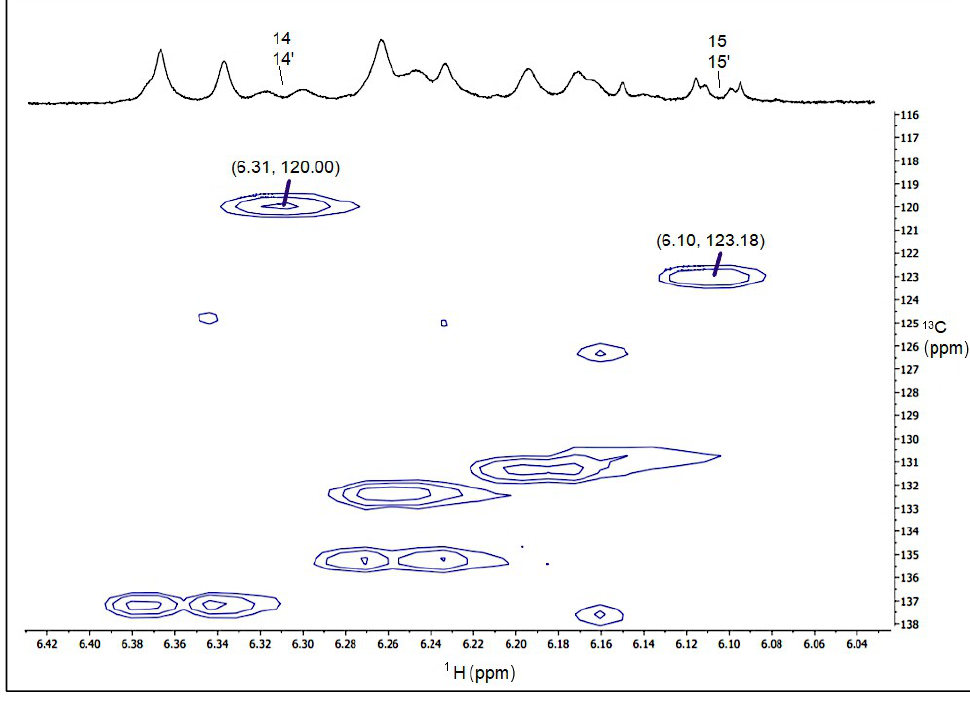
Figure 7. Region of mass spectra showing the molecular mass of phytoene derived from ( a ) ripe to- matoes (545.5081), ( b ) chlorpropham-treated D. salina (545.5073) and ( c ) norflurazon-treated D. salina (545.5080) , in positive ionisation mode [M + H] +